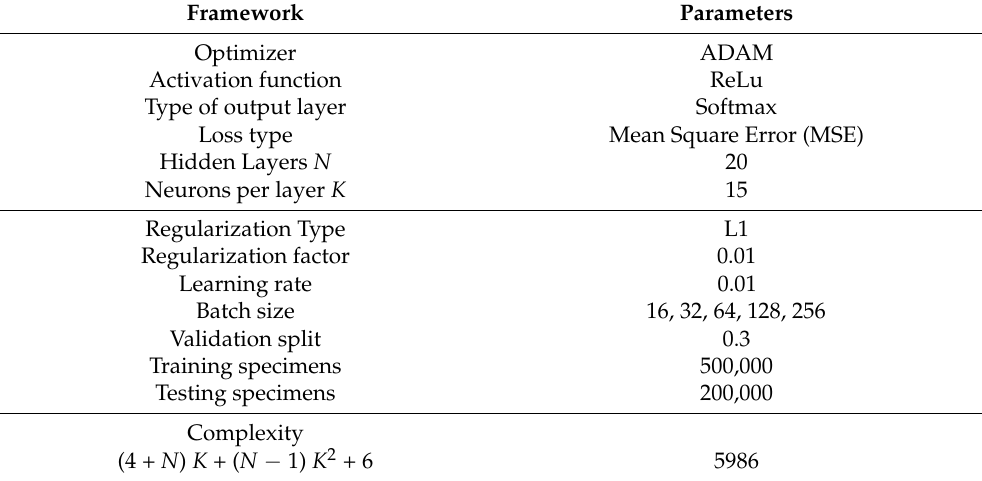
Table 3. CNN architecture